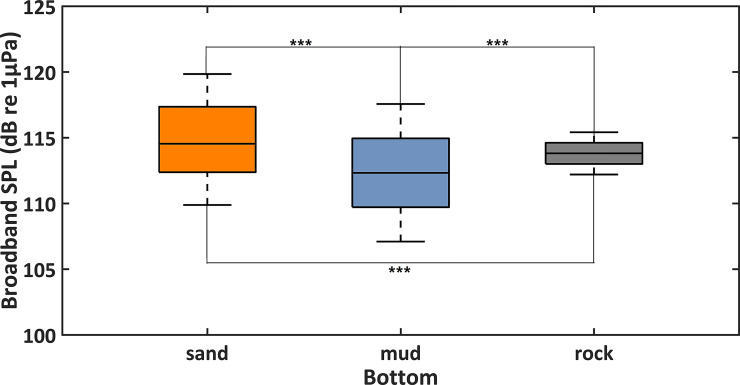
Comparison of broadband sound pressure levels (broadband SPLs) among different seabed environments.The three categories were muddy, sandy and rocky sea floors. Differences are marked with *** for p-level < 0.001 (Mann-Whitney U test).